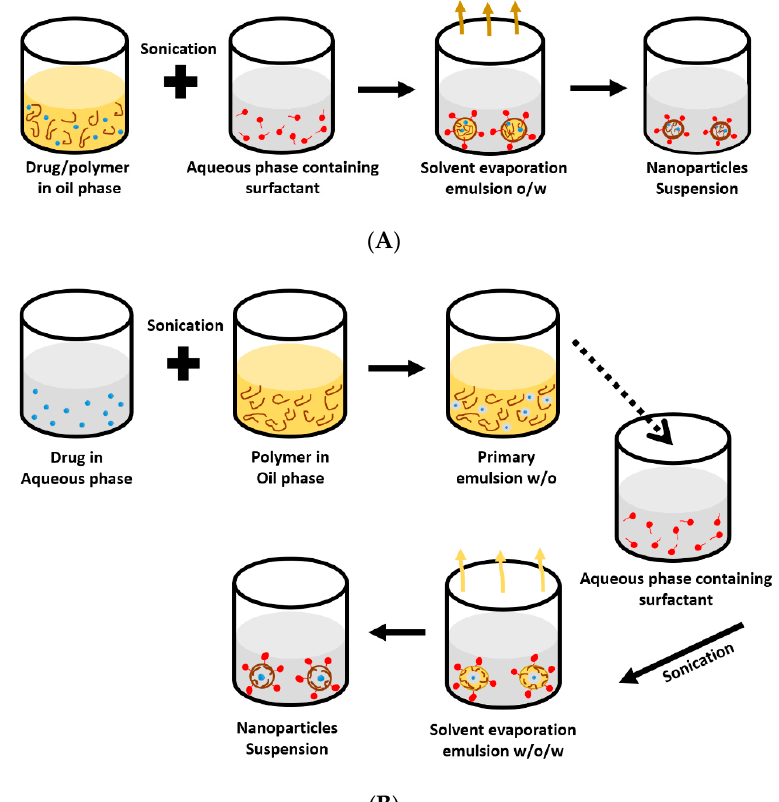
Figure 4. Schematic representation of nanoparticles formulated by single emulsion technique ( A ), and double emulsion technique ( B ).